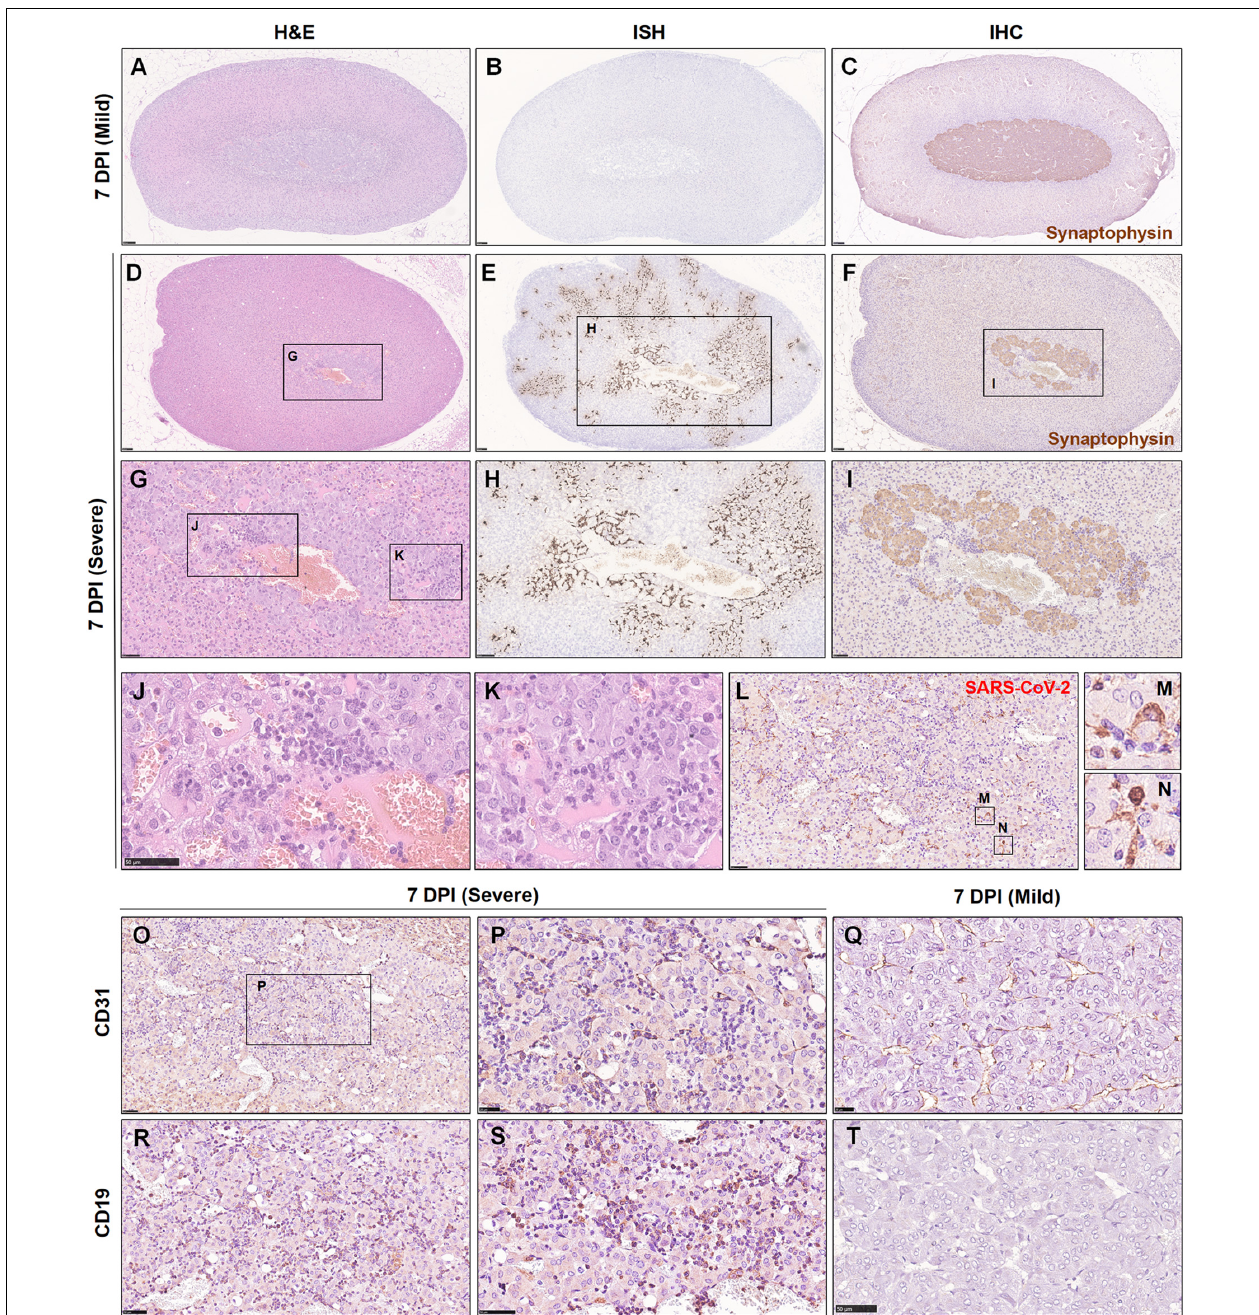
FIGURE 6 | The adrenal gland was severely affected, and SARS-CoV-2 was detected throughout the adrenal gland at 7 dpi. (A–C) Mild adrenal gland changes accompanied by few inflammatory foci were observed in one infected hamster at 7 dpi. (D,G,J,K) Multifocal inflammatory cells, mainly including neutrophilic cells and lymphocytes, were scattered in the adrenal cortex and medulla. (E,H) Robust viral RNA expression was detected by ISH in the adrenal cortex and medulla. (F,I) The adrenal medulla was atrophied, as confirmed by synaptophysin protein staining. (L–N) The expression of viral S protein was further confirmed by IHC, mainly in the cellular cytoplasm. (O–Q) Abundant vascular endothelial cells were stained for a biomarker, CD31. (R–T) A mass of CD19-positive cells was stained, confirming the aggregation of B lymphocytes. Sequential sections were stained by H&E and subjected to ISH and IHC. Data are representative of three independent experiments.